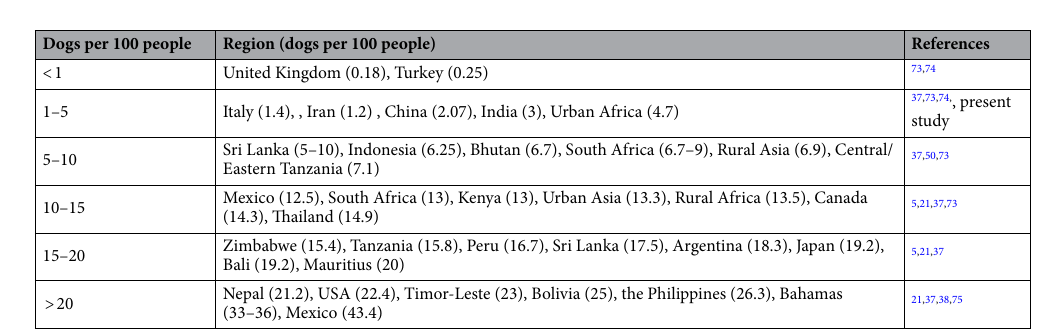
Table 3. Dog population density in different parts of the world presented as the number of dogs per hundred